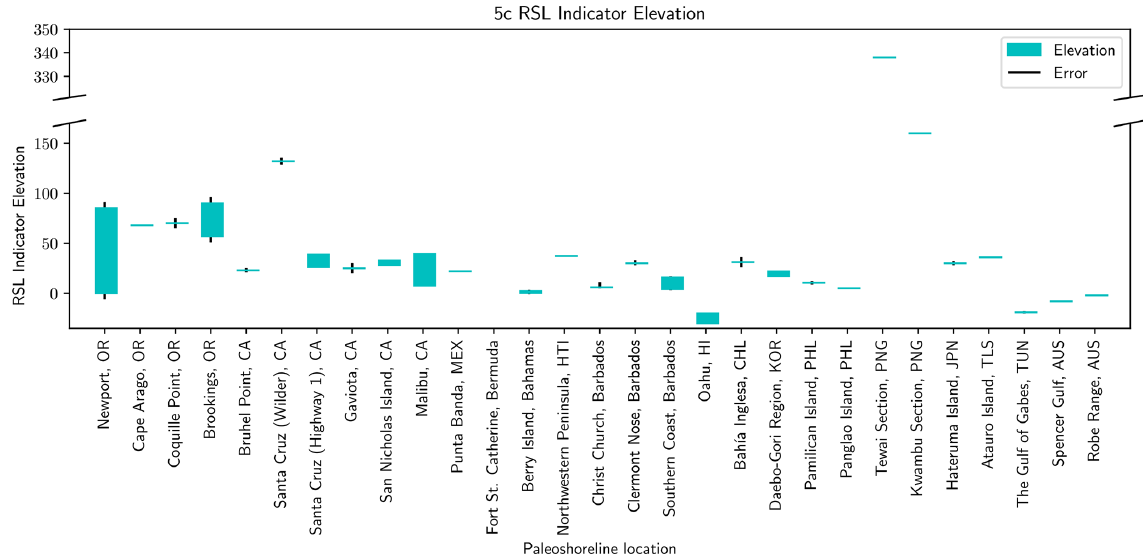
Figure 3. The present elevation of MIS 5c RSL indicators, in meters, at the field locations listed on the horizontal axis. Teal bars represent the full elevation range reported in the primary publications along with the corresponding measurement error, if any, in black bars. Note the scale break on the vertical axis necessary to present indicator elevations for sites with rapid tectonic uplift.